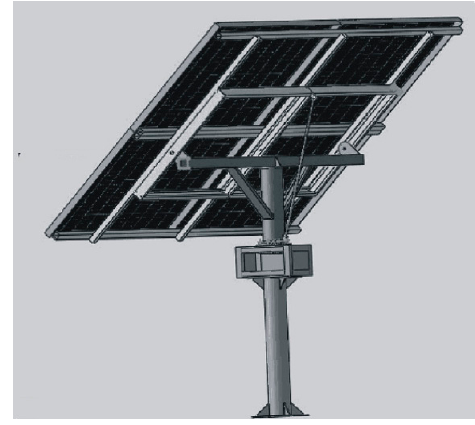
Figure 4. Proposed structure for the solar tracker.